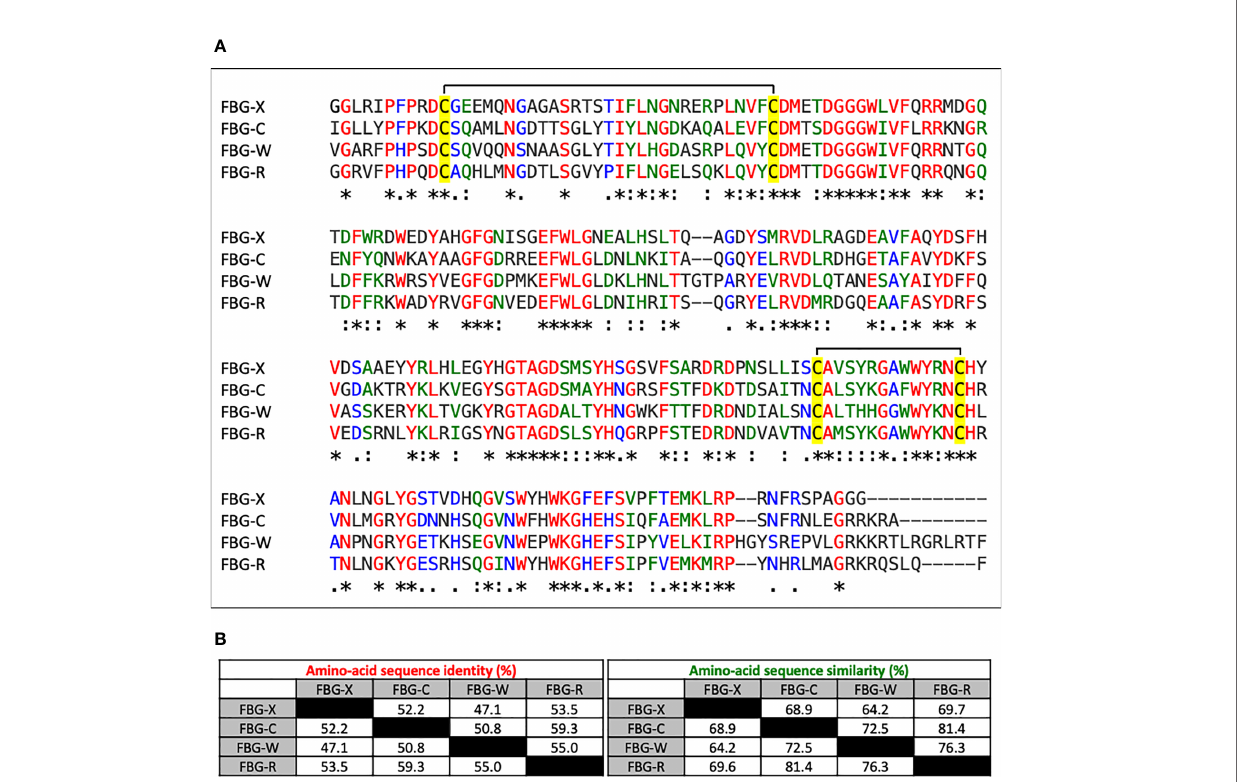
FIGURE 1 | Sequence alignment and homology degree between the Tenascin family FBG-like domains. (A) Multiple sequence alignment analysis of the FBG-like domains of human TN-X, -C, -W and -R (FBG-X, -C, -W, -R) performed with CLUSTALW software. Red (*) labelled residues are identical between the four FBG-like domains, green labelled (:) residues are highly conserved and blue labelled (.) residues are poorly conserved. The four conserved cysteine residues are highlighted in yellow. (B) Percentages of identity and similarity amongst the amino-acid sequences of the FBG-like domains of the human Tenascins performed with paired comparisons using CLUSTALW